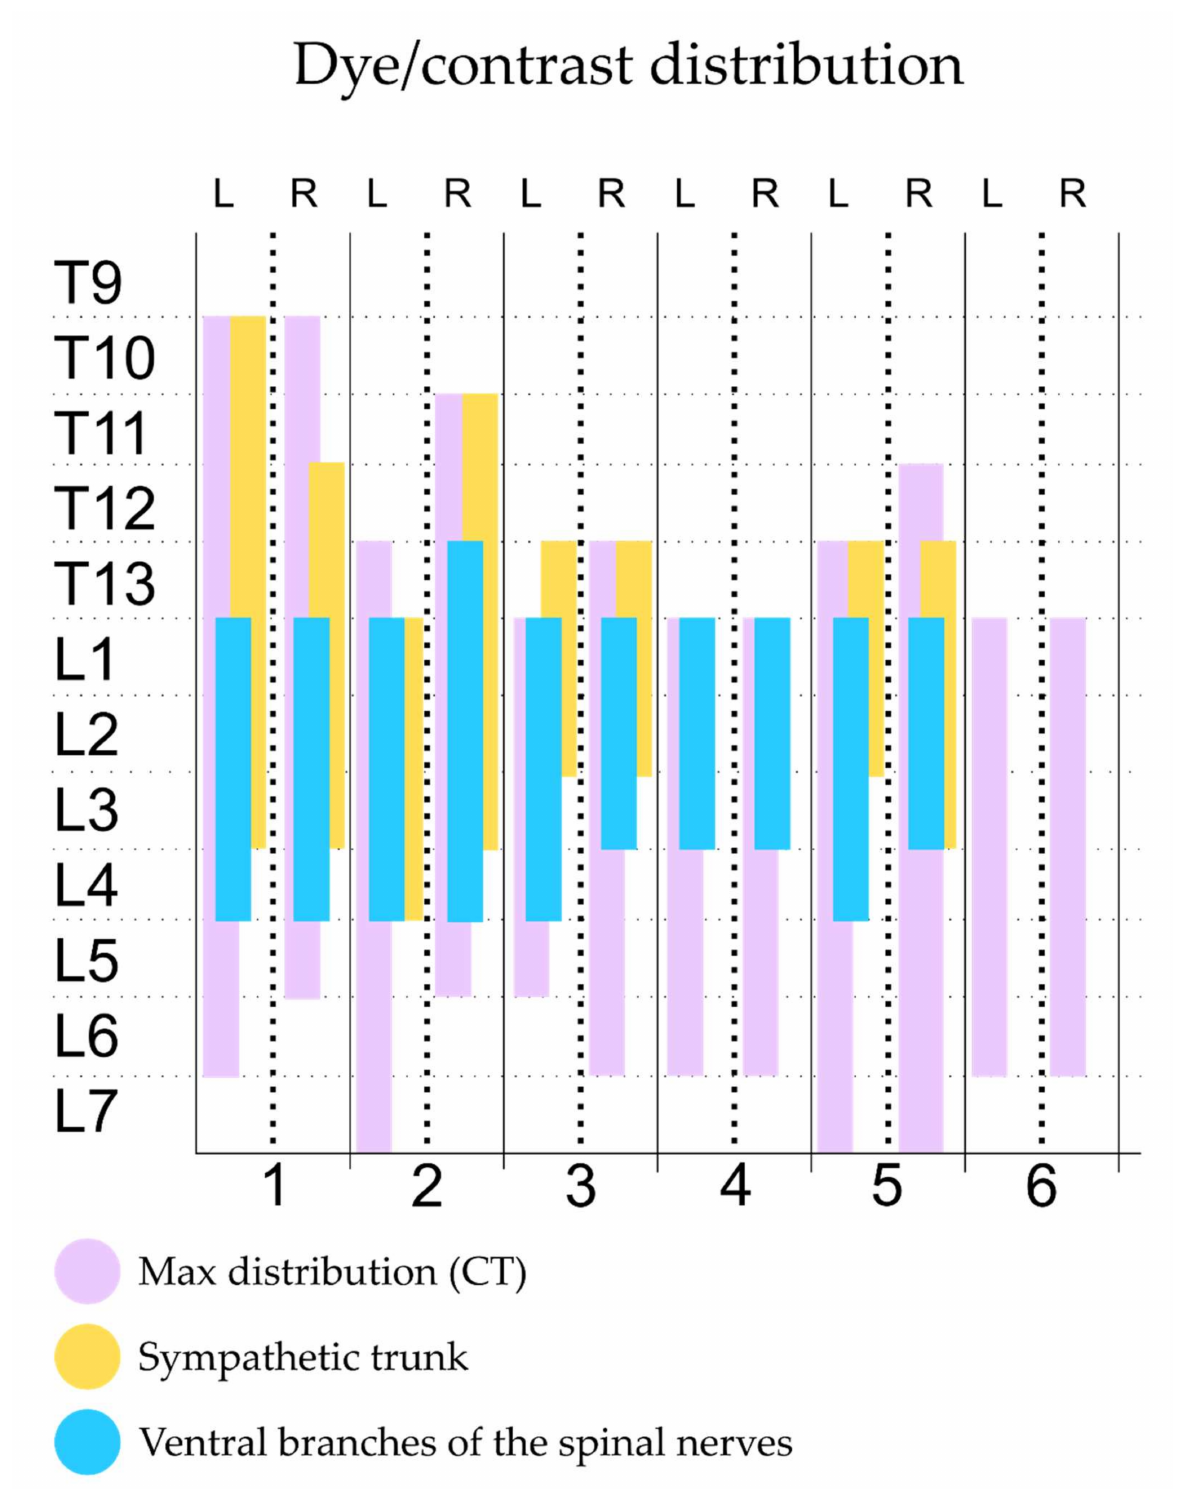
Figure 6. Staining of the ventral branches of the spinal nerves evaluated by computed tomographic and anatomical dissection after the administration of 0.6 mL kg − 1 of a mixture of methylene blue and iopromide by a modified QL approach. QL, quadratus lumborum block; L, left hemiabdomen; R, right